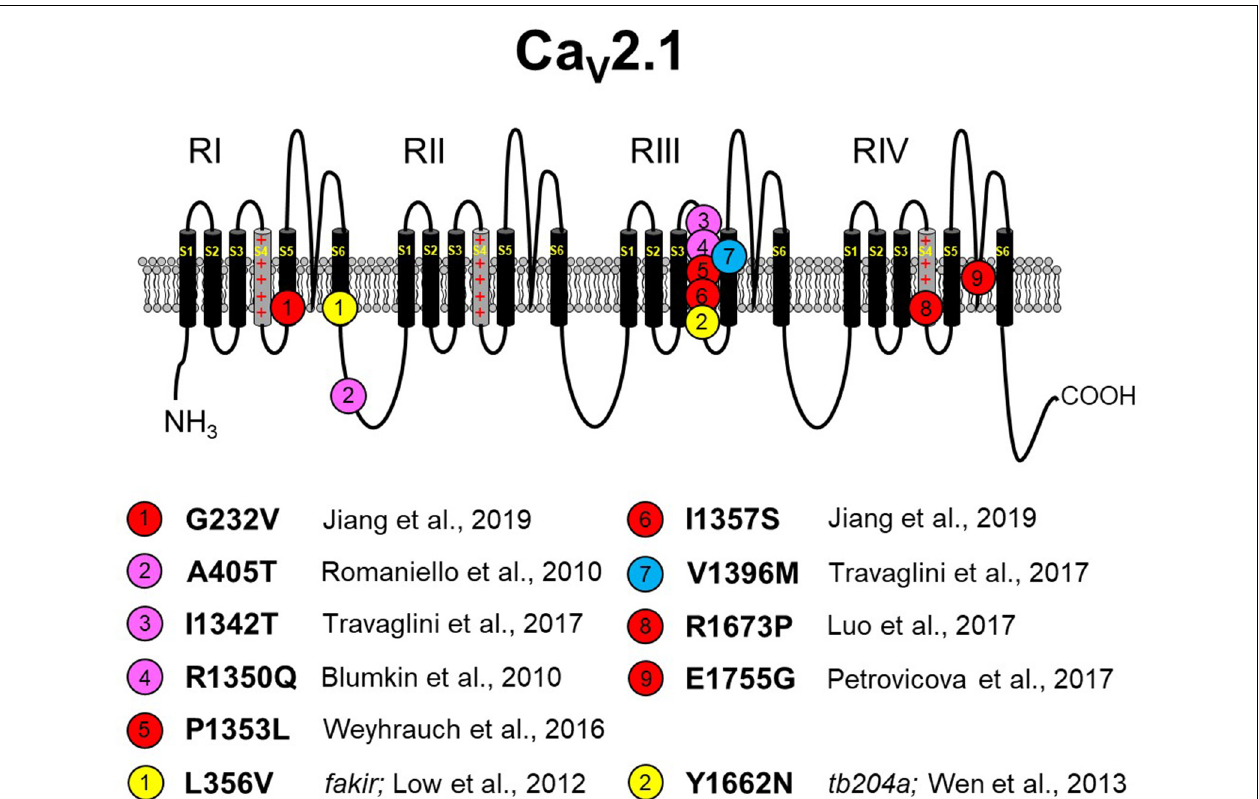
FIGURE 3 | Missense Ca V 2.1 mutations leading to neurodevelopmental disorders. The zebrafish fakir and tb204a mutants are also depicted as yellow circles. Red circles indicate a loss-of-function human mutation. Blue circles indicate a gain-of-function human mutation. Magenta circles indicate a yet-to-be functionally characterized human mutation. Specific references are indicated below. As in Figures 1 , 2 , please note that residue numbering varies between studies due to: (1) the existence of multiple known CACNA1A splice variants; and (2) species differences between humans and zebrafish. The Ca V 2.1 schematic was modified from Tyagi et al. (2019) with permission of the authors. These mutations are discussed in sections “The Expanding Spectrum OF Ca V 2.1- α 1A Channelopathies” and “Zebrafish as a Model SYSTEM for the Study of Severe Ca V 2.1